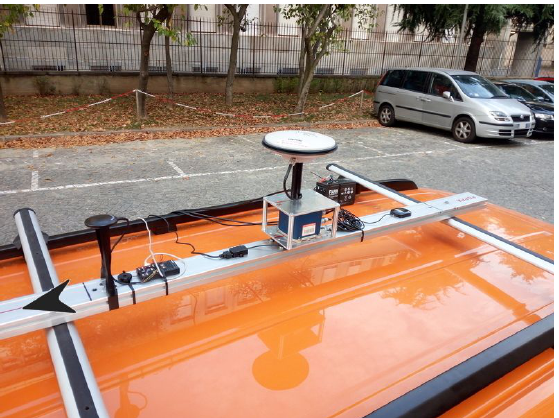
Figure 6. Sensors located on the crosswise bar on top of a vehicle. The black arrow on the left indicates the direction of